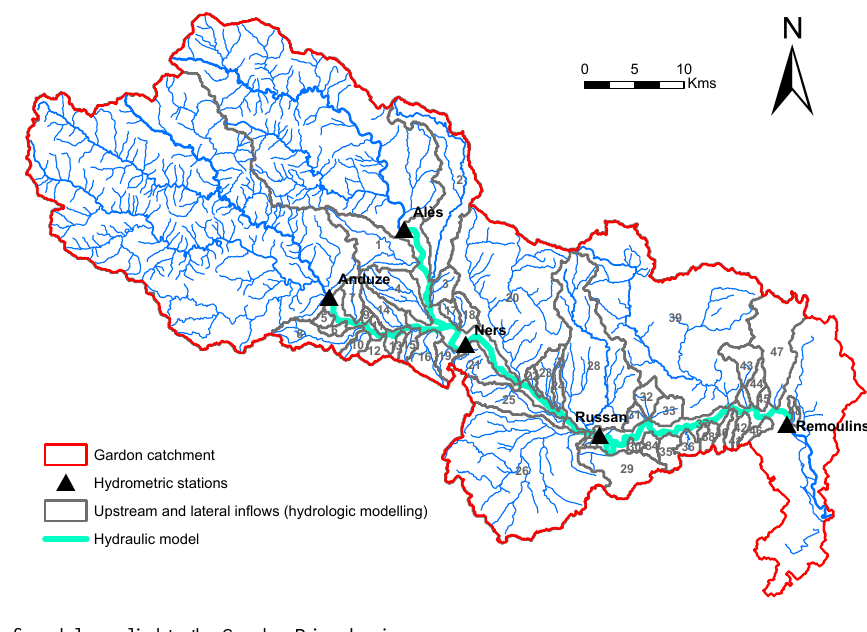
Figure 3. Coupling of models applied to the Gardon River basin.